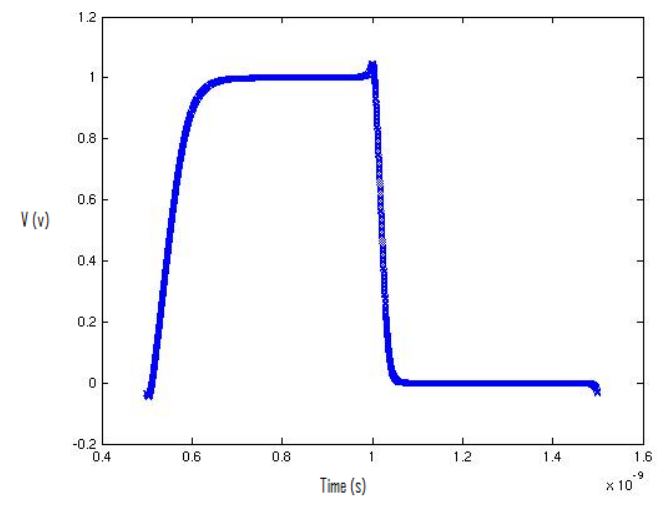
Figure 5. Inverter output plots (one cycle) in MATLAB.